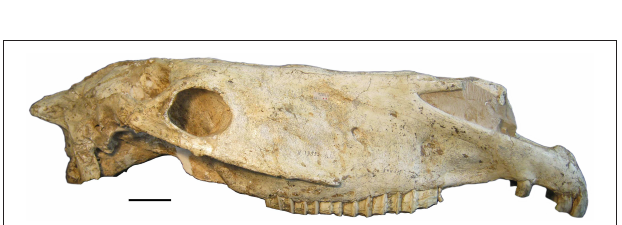
FIGURE 10 | Right lateral view of holotype skull of E. eisenmannae , IVPP V 13552, collected from Longdan Locality, Linxia Basin. Scale bar =